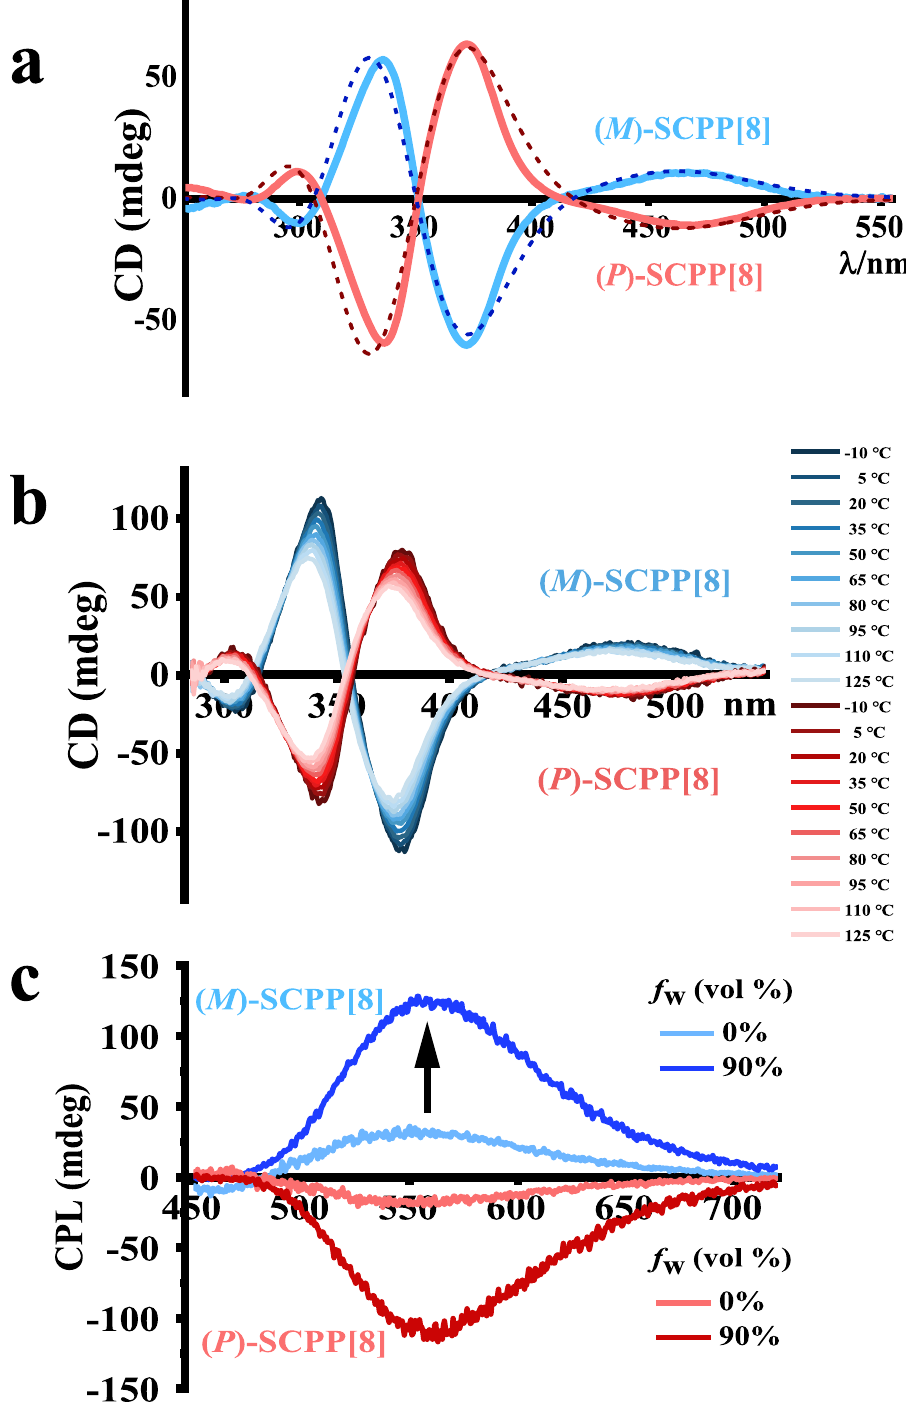
Fig. 6 Chirality and enhanced CPL. a Experimental and theoretical CD spectra for ( P )-SCPP[8] and ( M )-SCPP[8] . The solid lines are the experimental spectra of ( M )-SCPP[8] (blue) and ( P )-SCPP[8] (red) in dichloromethane. The dashed lines are theoretical spectra of ( M )-SCPP[8] (dark blue) and ( P )- SCPP[8] (dark red) from TD-DFT calculations. b Temperature-dependent CD spectra of ( M )-SCPP[8] (blue) and ( P )-SCPP[8] (red) from − 10 to 125 °C at 15 °C intervals. c CPL spectra of ( M )-SCPP[8] (blue) and ( P )-SCPP[8] (red) in THF solution and in 90:10 H 2 O/THF solution. Excited at 355 nm.